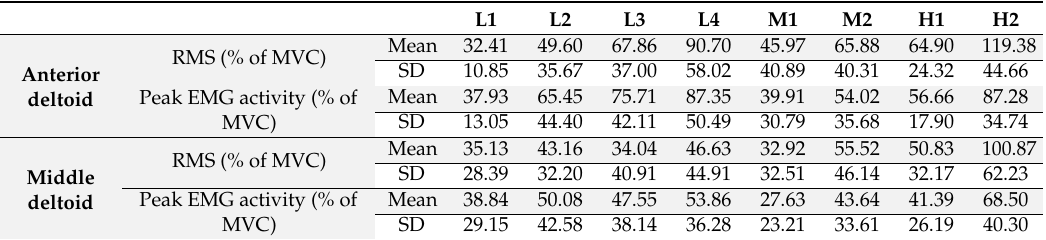
Table 2. Mean and SD of normalized EMG activity (area under the curve and peak EMG activity) for anterior and middle